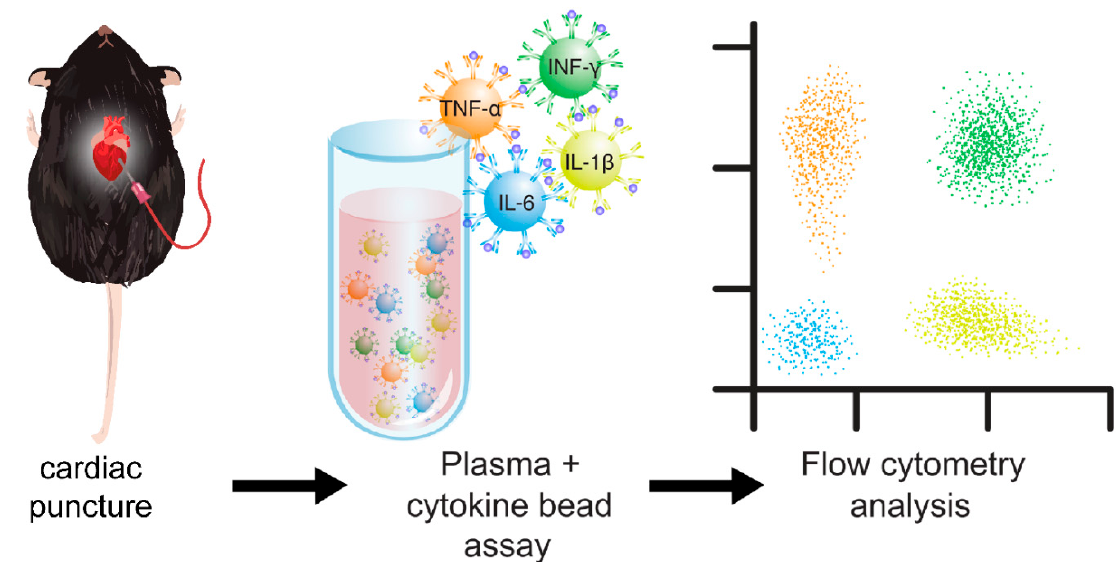
Figure 1. Schematic diagram of Cytokine Bead Assay (CBA) analysis used for determination of tumour necrosis factor-alpha (TNF-alpha), interferon-gamma (IFN-gamma), Interleukin-6 (IL-6), and Interleukin-1 beta (Il-1 beta).